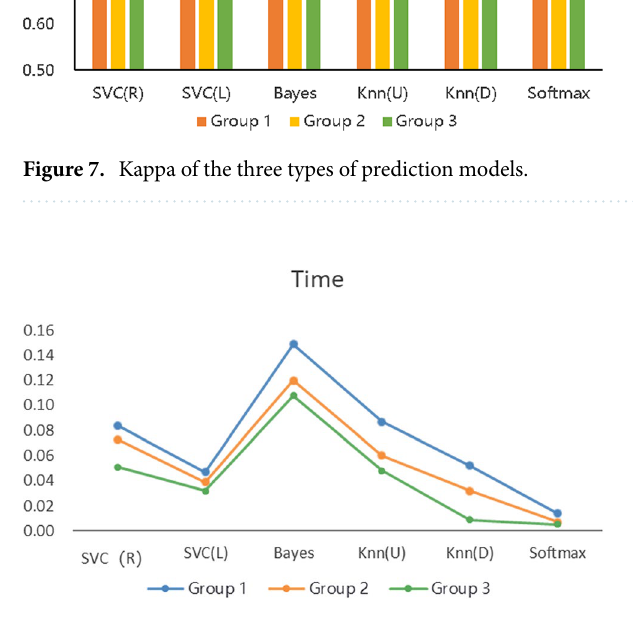
Figure 8. Computation time required for each of the three types of prediction